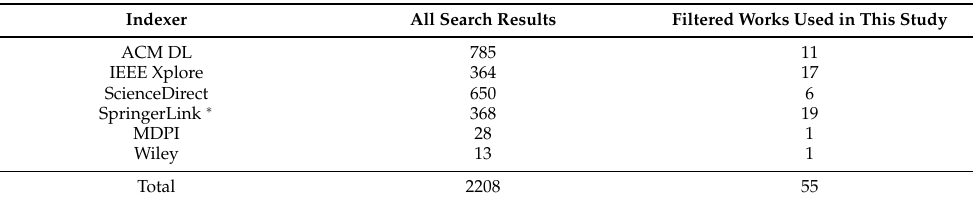
Table 2. Search results from the query applied across scientific indexers, all results and filtered results assessed in this study. Refer to Table 3 for specific works and classification.